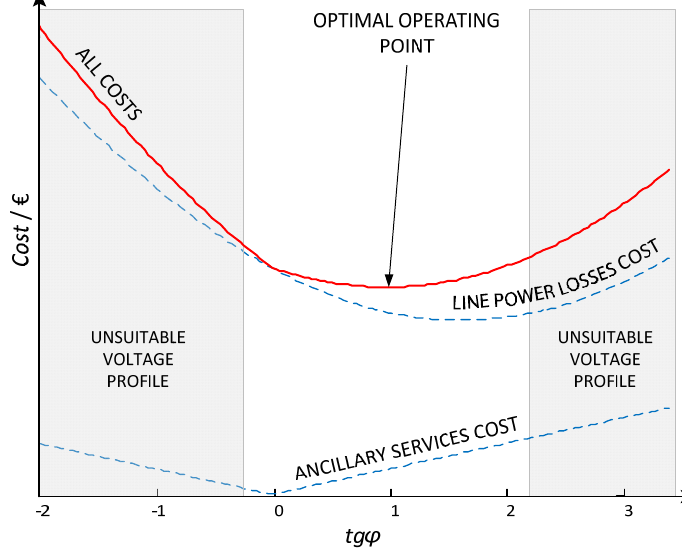
Figure 5. Principled graphical representation of the optimization